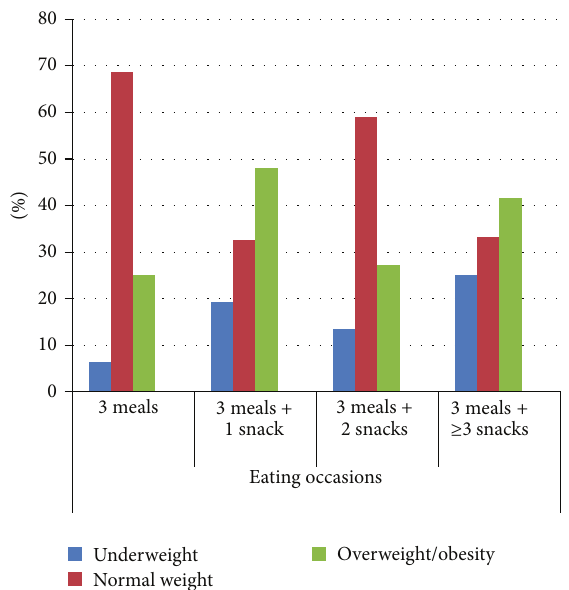
Figure 3: Comparison of eating occasions and nutritional status of female